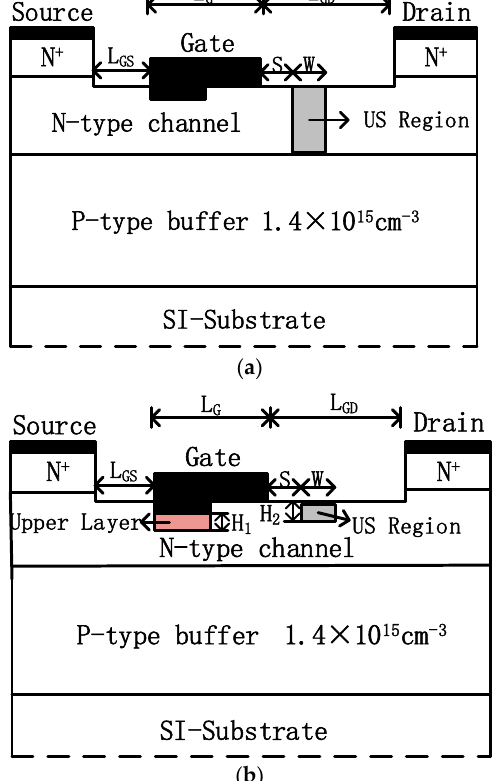
Figure 1. Schematic cross sections of the ( a ) double-recessed 4H-SiC MESFET with partly undoped space region (DRUS-MESFET), ( b ) 4H-SiC metal semiconductor field effect transistor with layered doping and undoped space regions (LDUS-MESFET).